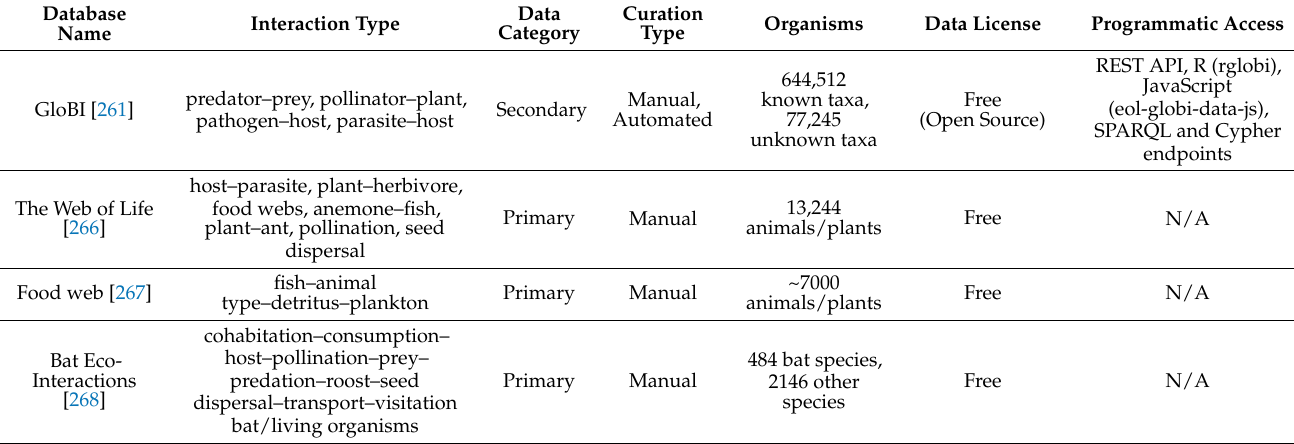
Table 10. Ecological interactions